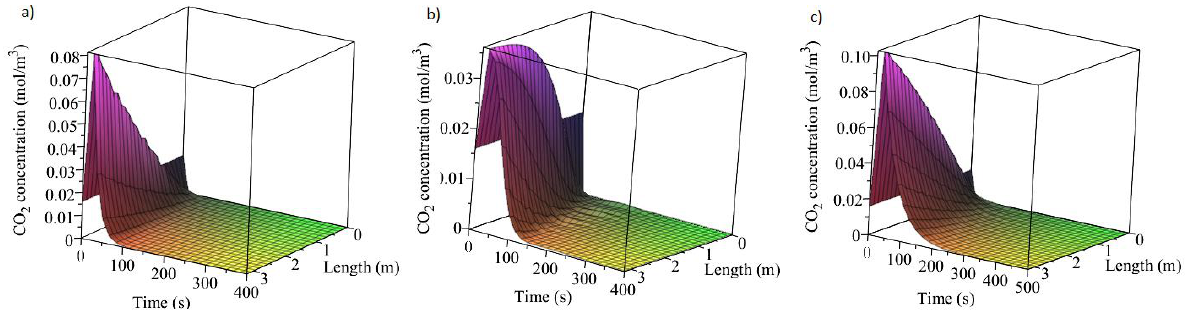
Figure 7. CO 2 concentration during the desorption step for physisorbents: ( a ) MIL-101, ( b ) MOF-177, and ( c ) MOF-5.